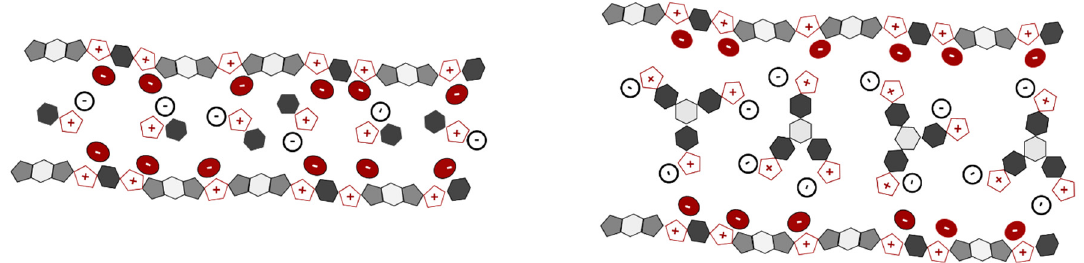
Figure 2. Graphic representing the incorporation of mono- and tris-imidazolium ionic liquid (IL) within the ionene matrix. The cartoon structures refer to the polymer and IL structures shown in Scheme 3. For example, pentagon are five-membered rings, hexagons are six-membered rings and circles are anions.